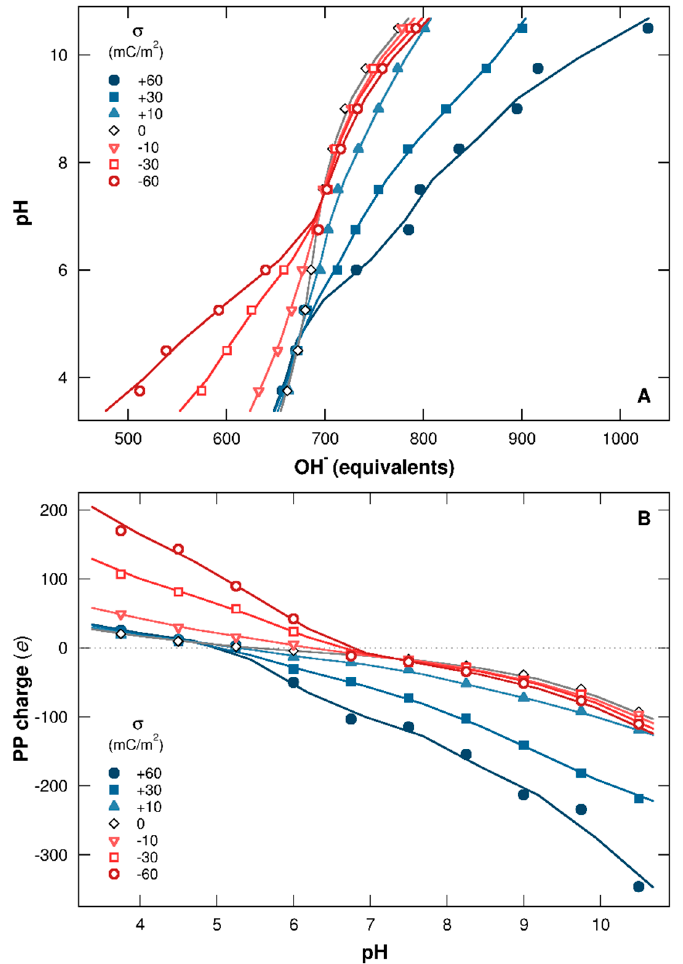
Figure 2. ( A ) PP titration curves (pH as a function of OH - equivalents) and ( B ) total charges per chain (in elementary charges) calculated for NP surface charge densities ranging from − 60 to +60 mC/m 2 . Red open symbols and blue closed symbols represent cases with negative and positive NPs. Neutral NP behavior is shown by black open symbols.